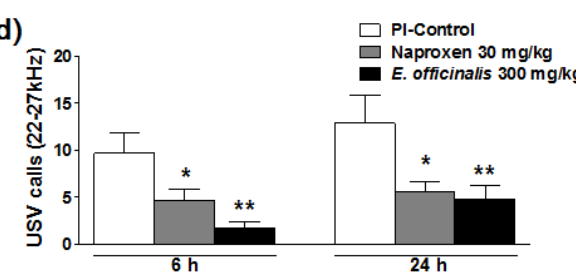
Figure 2. Effect of E. officinalis extracts on ultrasonic vocalization (USV) induced by plantar incision in rats. The sonograms of USVs in a ( a ) control; ( b ) naproxen; and ( c ) E. officinalis extracts ‐ treated rats; ( d ) A significant difference was observed in the number of 22–27 kHz USV calls was observed between the E. officinalis extract ‐ treated group and the control group. Data represent the mean ± SEM ( n = 9 per group). * p < 0.05 and ** p < 0.01, significant difference from the control group. PI ‐ Control: plantar incision in the control group.